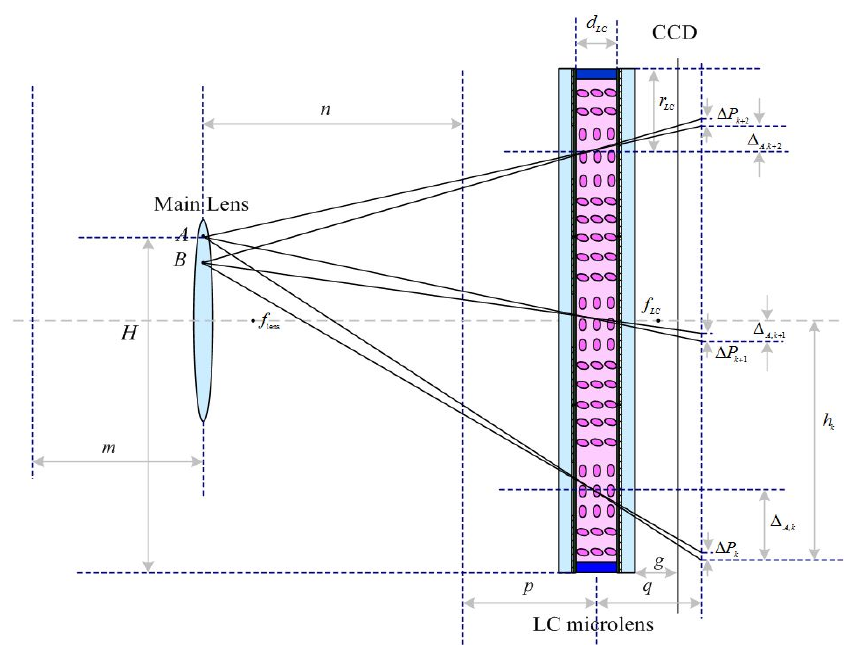
Figure 6. Schematic diagram of aperiodicity extracting the view angle image in light field imaging based on LC microlens.